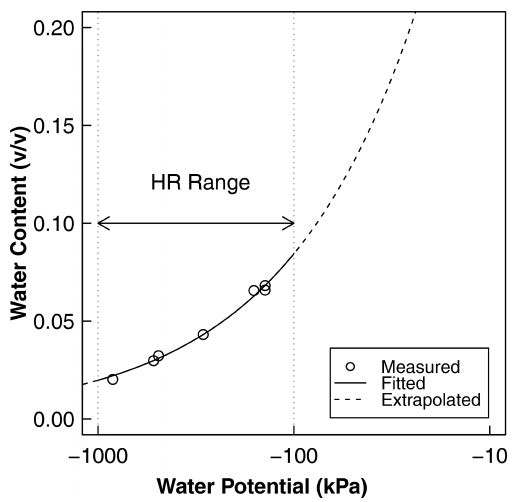
Figure A1. Water retention as a function of water potential de- rived from independent soil characterization. The points represent the measurement of water content and water potential using the po- tentiometer, and the solid line is the best-fit Brooks–Corey model. The measurement points adequately cover the range of water poten- tial at which HR was observed using psychrometers. These curves were used for the conversion of water potential to water content and the calculation of HR water flux, as shown in Fig. 7b, c, and d. The fitted parameters of the curve are the air entry water potential ( ψ 0 : − 6 . 51kPa) and the dimensionless shape factor ( λ : − 0 . 63). The saturated water content was estimated from the bulk density as saturated water content, θ s : 0 . 47 v/v , and the residual water con- tent was assumed to be